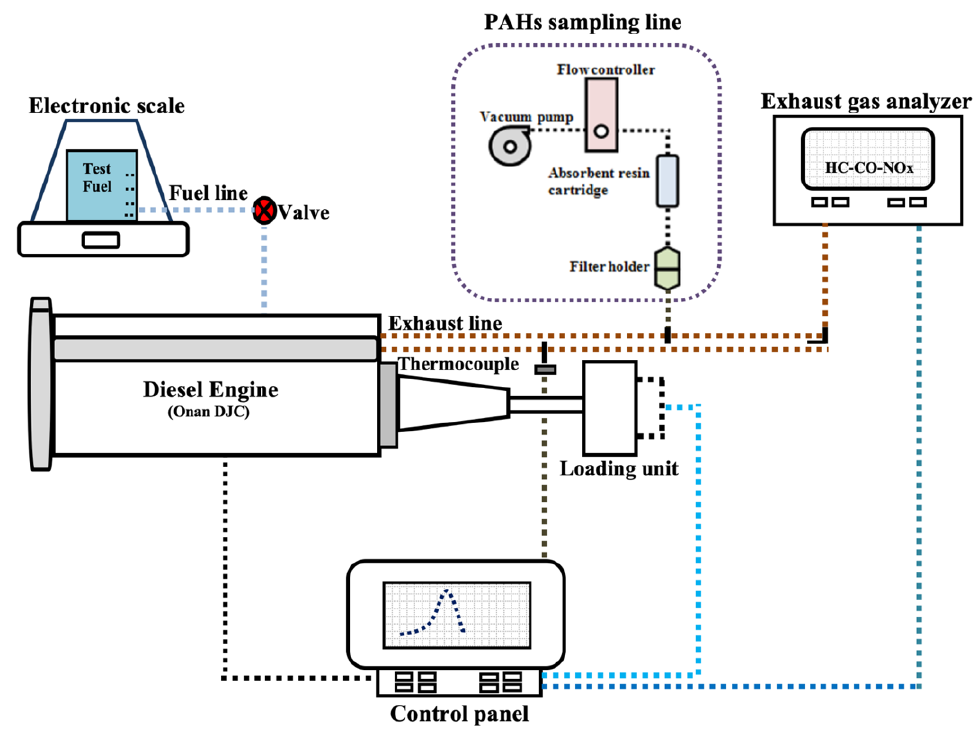
Figure 1. Experimental facility. Table 2. The basic chemical properties of test fuels.